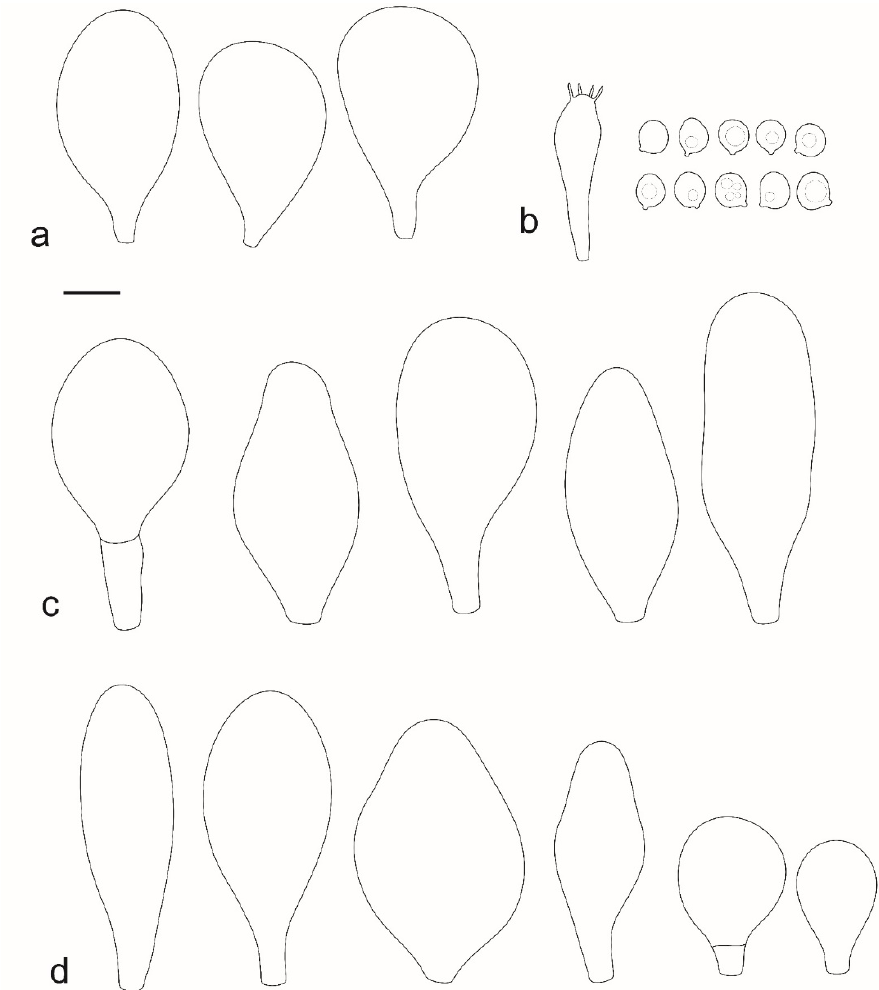
Figure 7. Pluteus aff. romellii : ( a ). pileipellis elements, ( b ). basidium and basidiospores, ( c ). pleuro- cystidia, ( d ). cheilocystidia. Scale bars 10 µm.